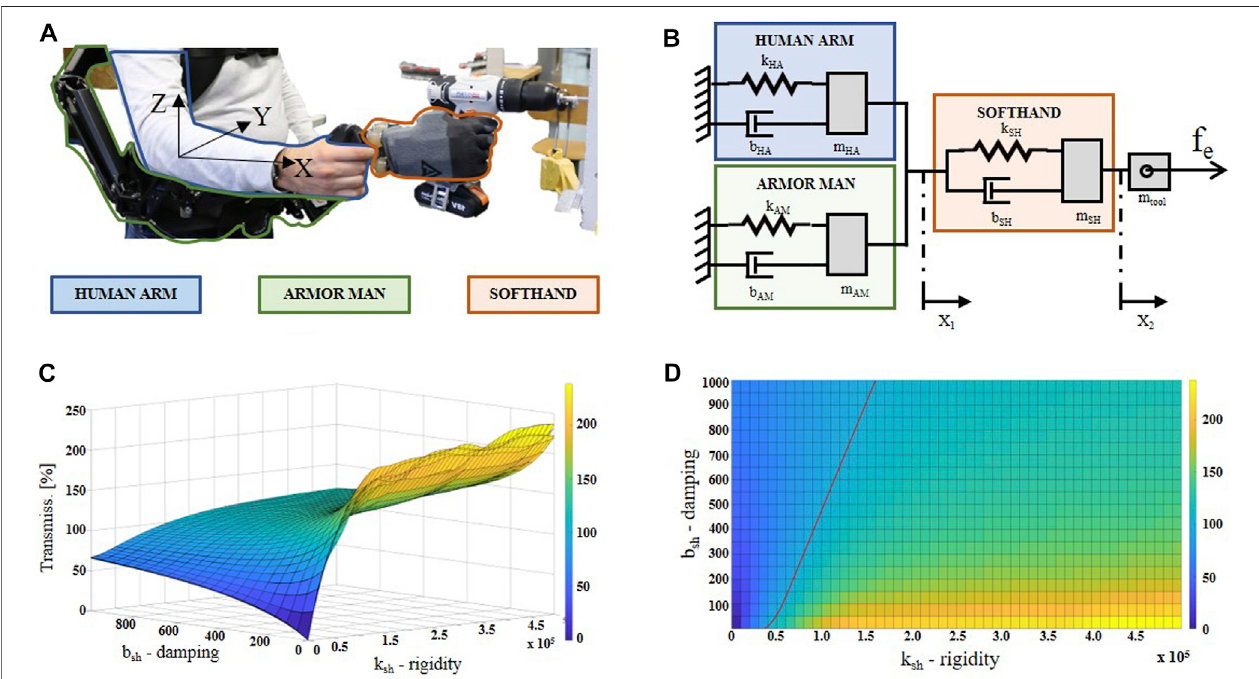
FIGURE2| In (A) ,thelumpedmodel ofthepresentedsupernumeraryroboticsystemisshown.Parameters k i , b i , and m i are, respectively,the springstiffness, the damping, and the mass of the Human Arm ( i (cid:2) HA ), Armor Man ( i (cid:2) AM ), and SoftHand ( i (cid:2) SH ) sub-models. m tool is the mass of the vibrating working tool that imposes an external force f e . In (B) , the three sub-models are highlighted with colors on a subject wearing the system and holding a drill. In (C) and in (D) , the vibration transmissibility from m SH to m HA is plotted (3D and top view, respectively), varying the k SH and b SH values. The red line in (D) represents the 100% transmissibility border: on the right of the line, the transmissibility is over 100%.